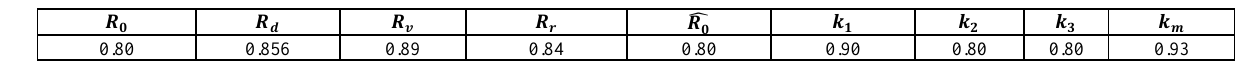
Table 2. Model parameter values for each